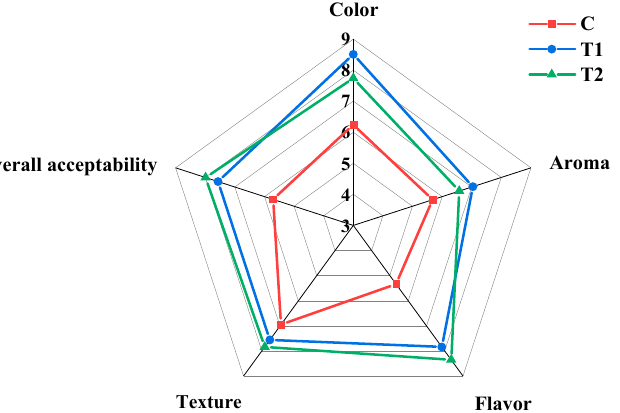
Figure 5. Sensory evaluation of MPR samples with different processing. C: Control group; T1: